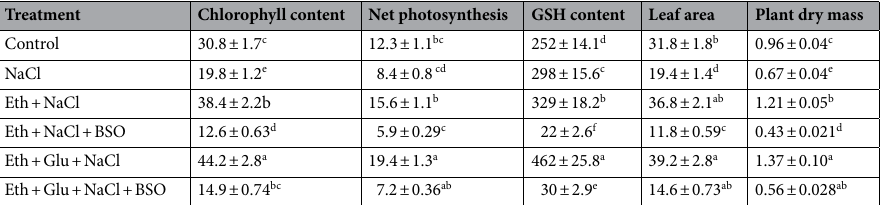
Table 4. Chlorophyll content (SPAD value), net photosynthesis (µmol CO 2 m −2 s −1 ), content of reduced buthionine sulfoximine (BSO) at 30 d after sowing. Data are presented as treatment mean ± SE (n = 4). Data followed by the same letter are not significantly different by LSD test at p <